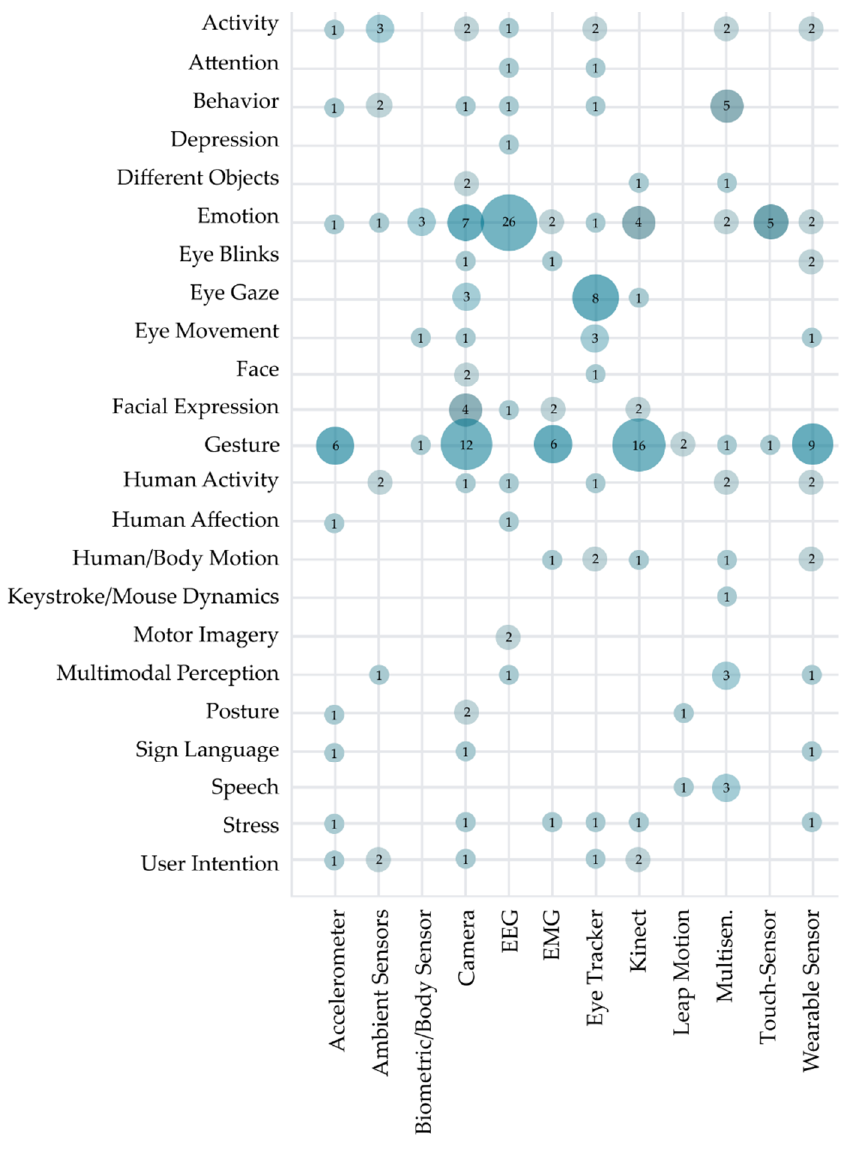
Figure 15. Distribution of sensors in existing HCI recognition solutions.